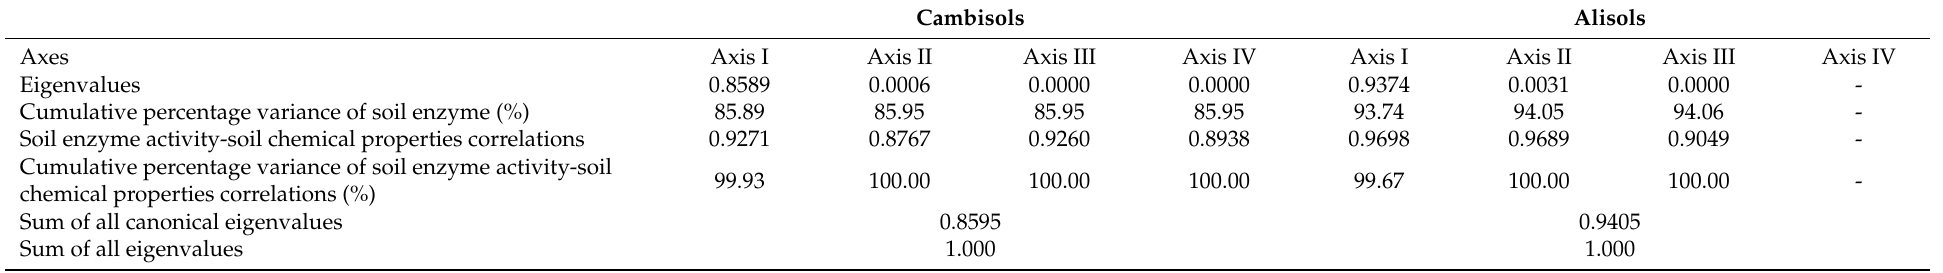
Table 3. Summary of the RDA results for soil enzyme activities in relation to soil chemical properties.